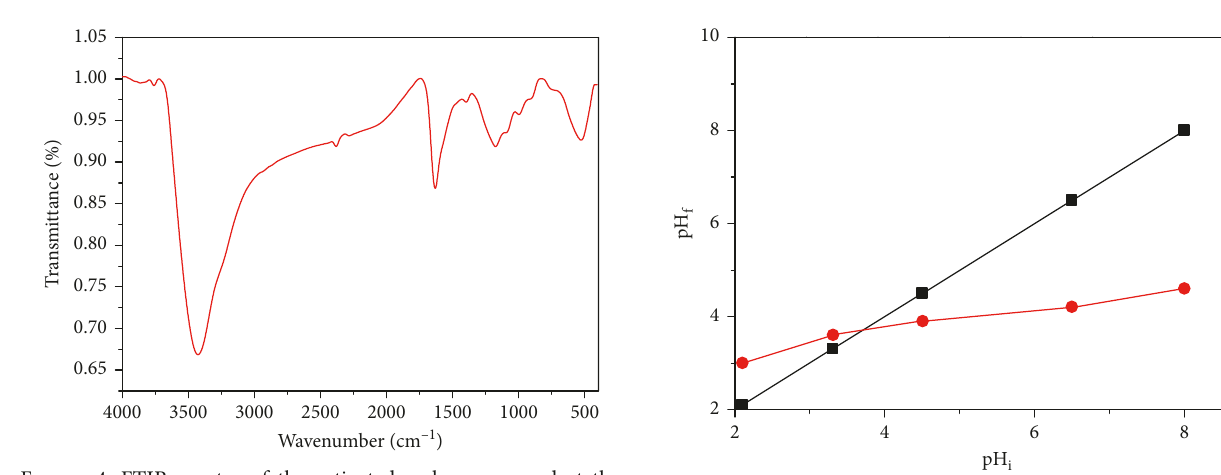
Figure 4: FTIR spectra of the activated carbon prepared at the optimal conditions.